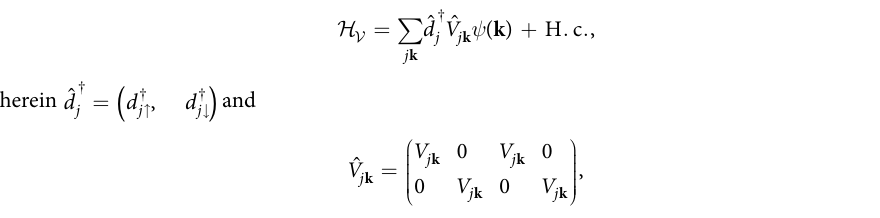
and d j σ being respectively creation and anni- j